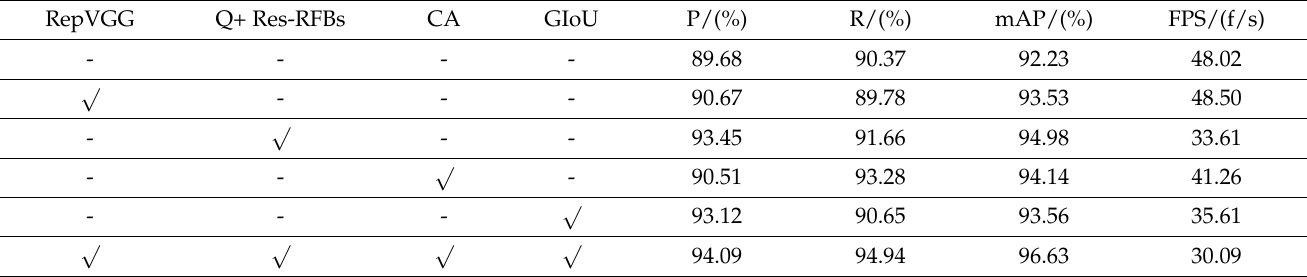
Table 2. Ablation experiment of the improved module. P stands for precision rate, R stands for recall rate, FPS stands for frame per second, and mAP stands for mean average precision. RepVGG Q+ Res-RFBs CA